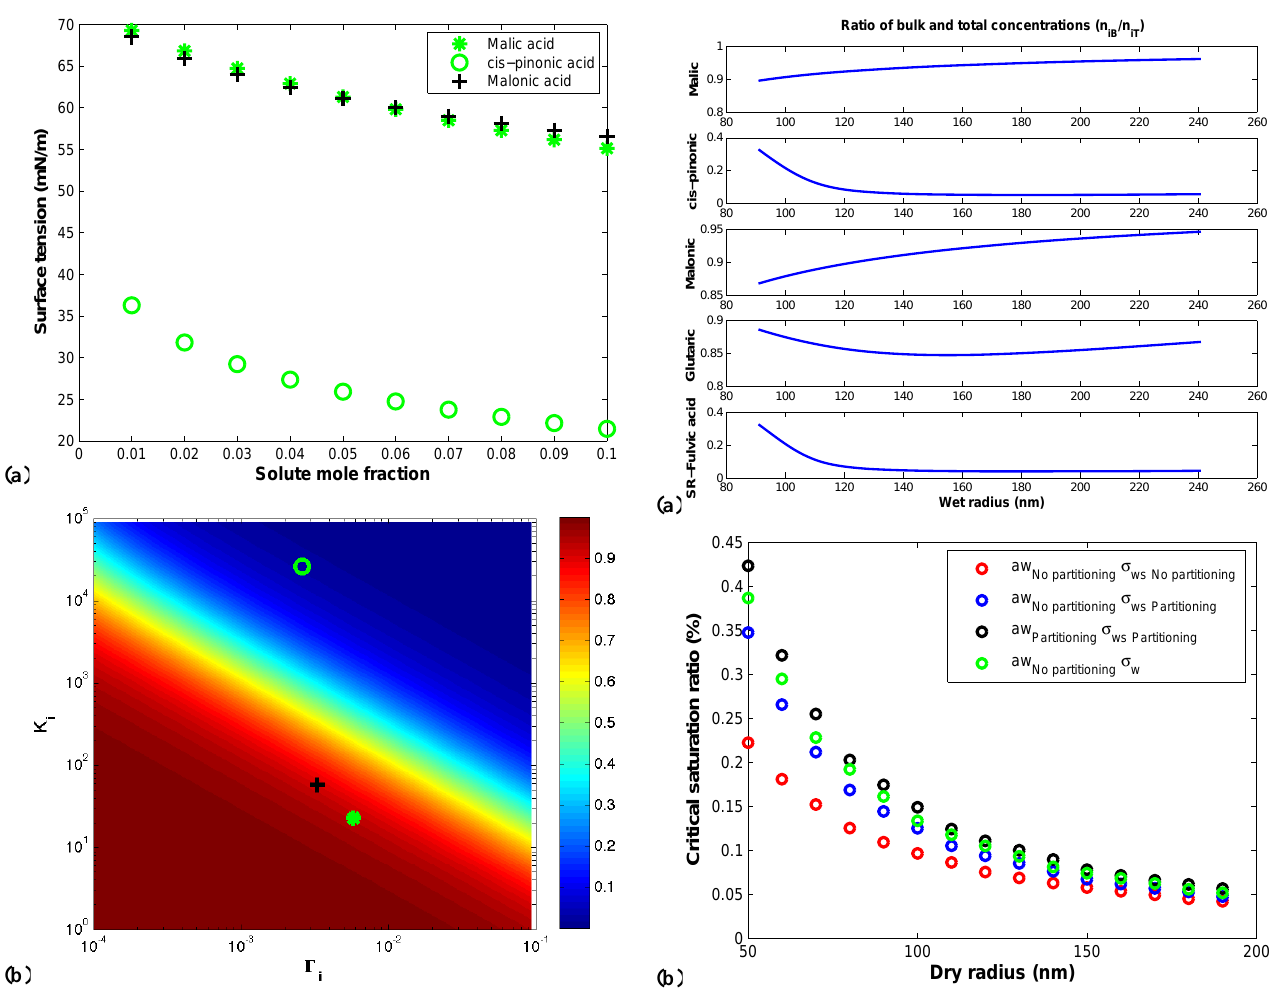
Fig. 2. (a) Ratio of bulk and total concentrations as a function of wet droplet size for a dry 50nm aerosol. (b) Critical saturation ratio as a function of dry size for different model permutations. See Sect.